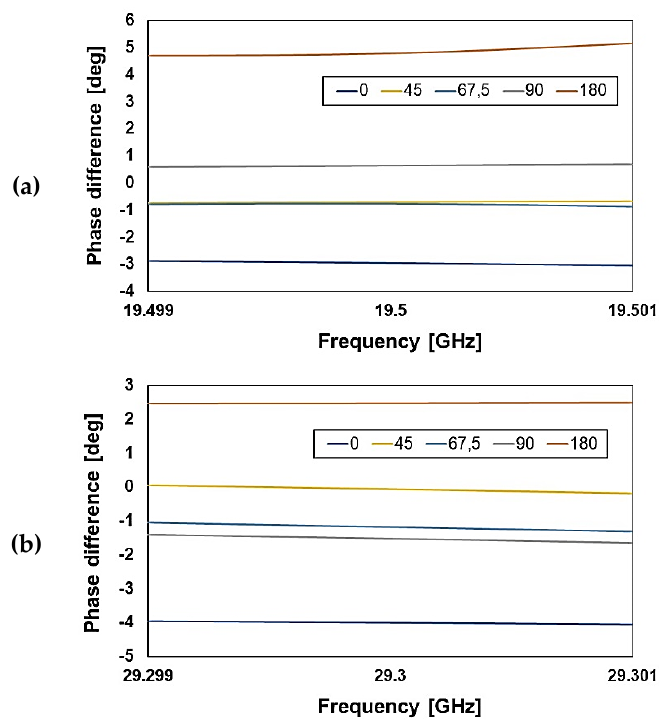
Figure 12. The phase difference between simulations and measurements at the center frequencies for the ( a ) K band and ( b ) Ka band RF-MEMS phase shifters.